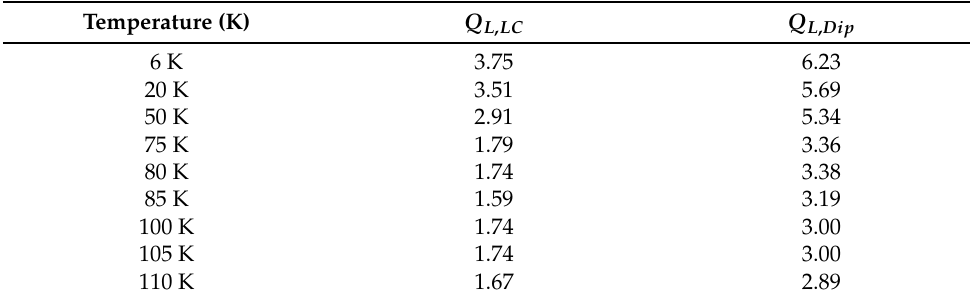
Table A2. Loaded quality factors associated with both LC and dipolar resonances for complementary device at different